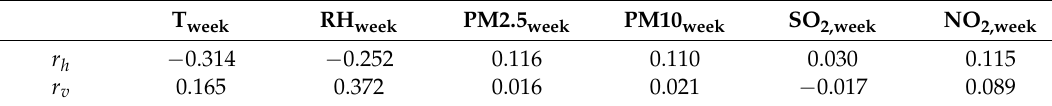
Table 2. The result of TDC analysis (week).